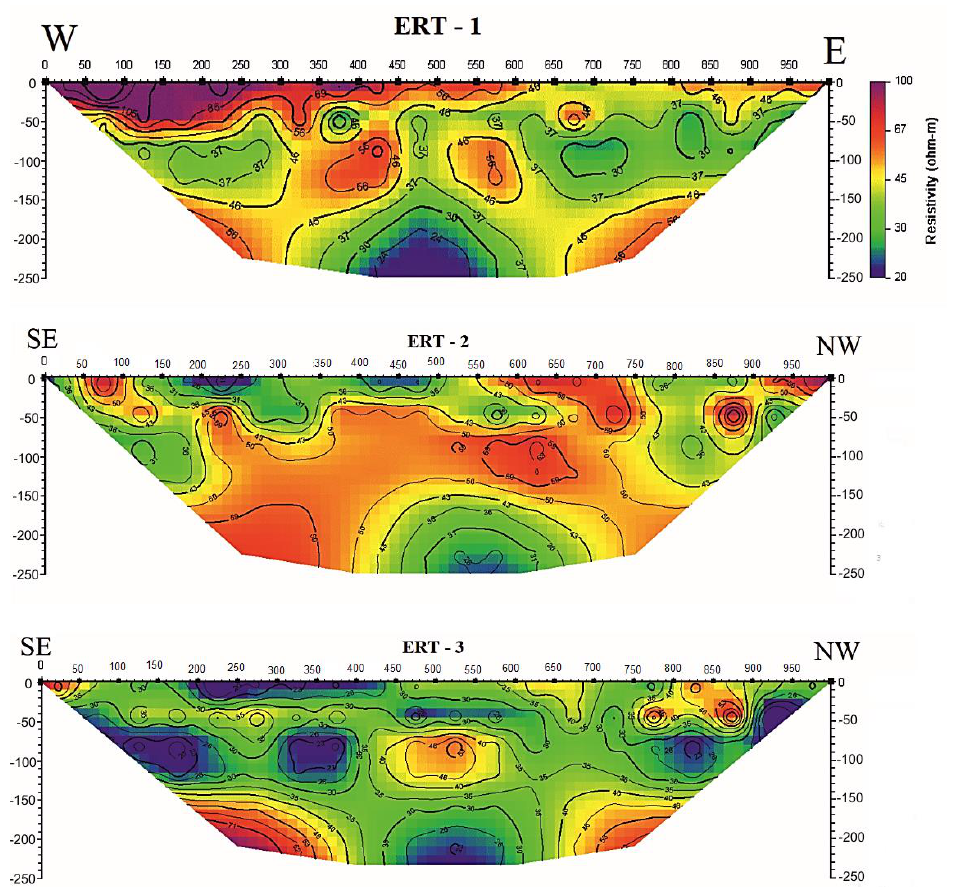
Figure 4. Electrical resistivity tomography (ERT) of the study area (from top to bottom, ERT1, ERT2, and ERT3 respectively).